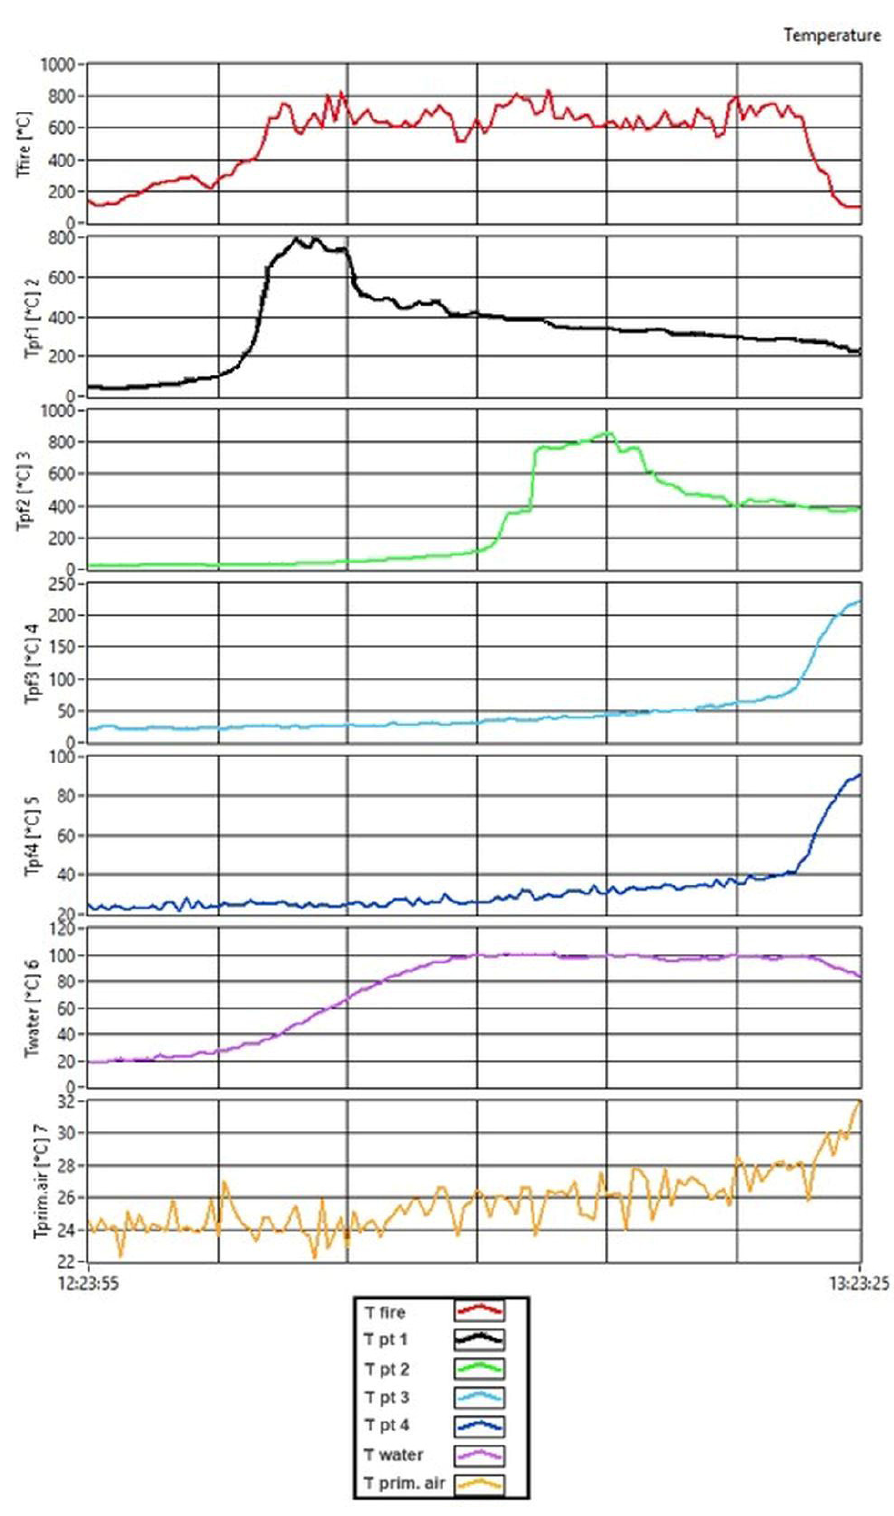
Figure 18. Evolution of temperatures acquired during the test with a ratio of 1/3 and an additional secondary flow rate (50%) of 25/75 L/min.